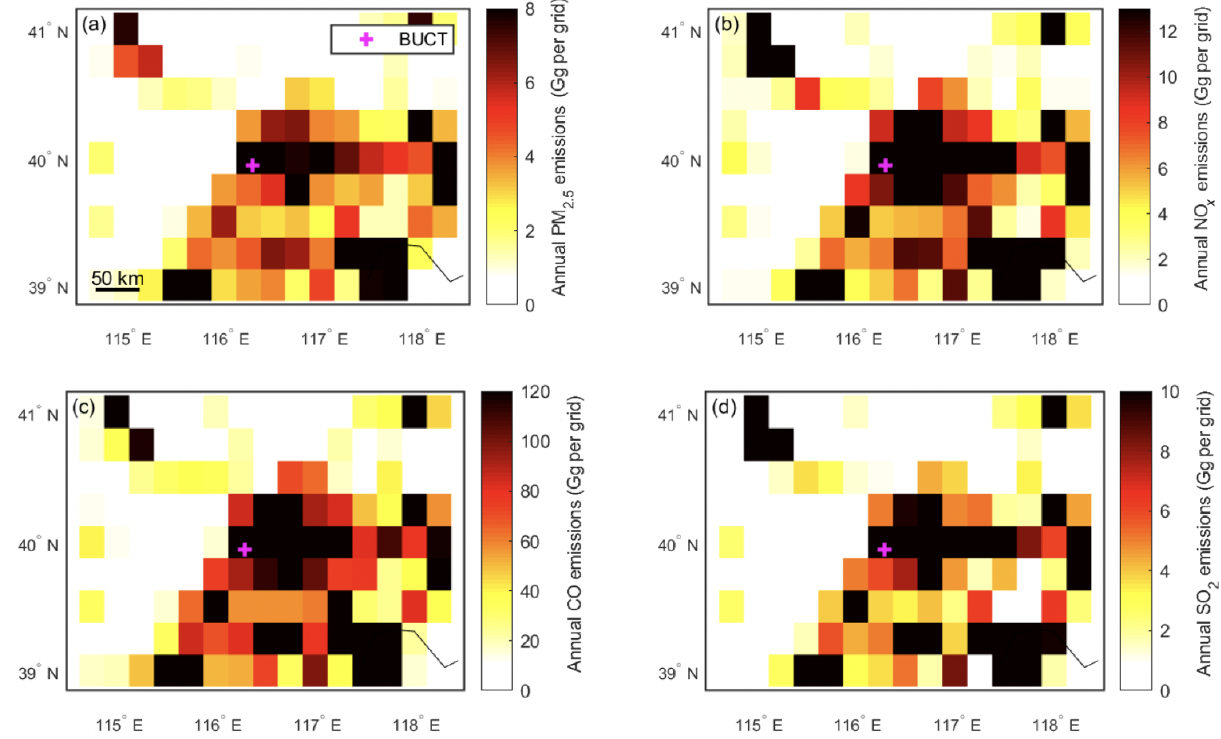
Figure A1. Annual emissions of (a) PM 2 . 5 , (b) NO x , (c) CO, and (d) SO 2 for the year 2010 based on the MIX emission inventory (Li et al., 2017) in the region around Beijing.